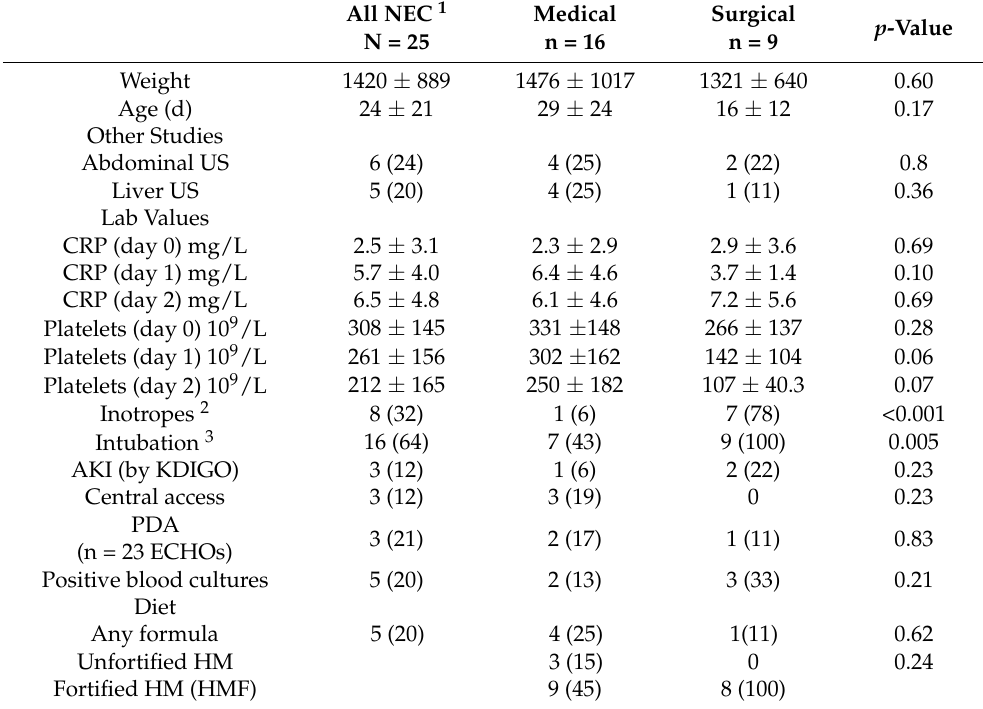
Table 3. Factors at